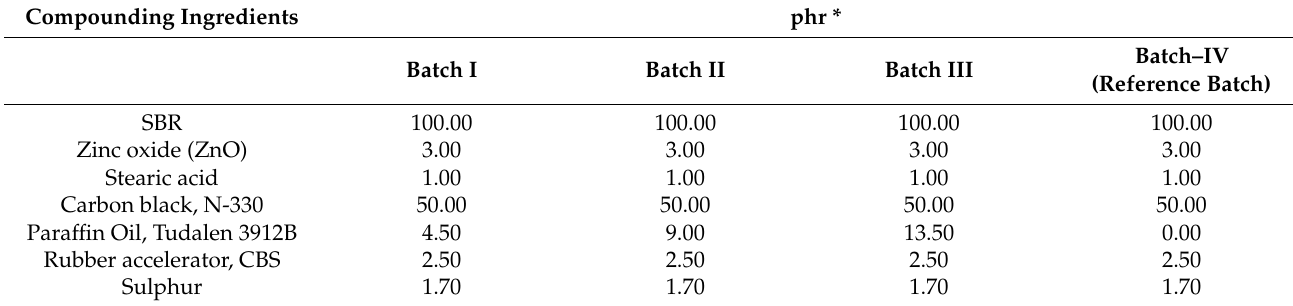
Table 1. Compositions of the various prepared batches.